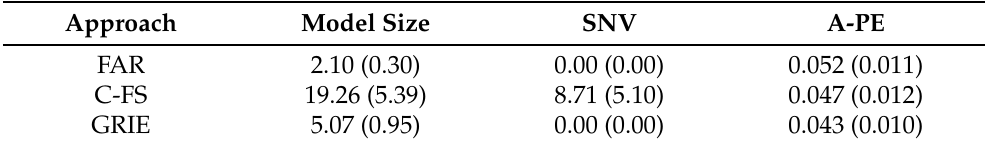
Table 7. Average numbers of model size, the number of SNV, and A-PE over 100 repetitions and their robust standard deviations (in parentheses) of Boston Housing